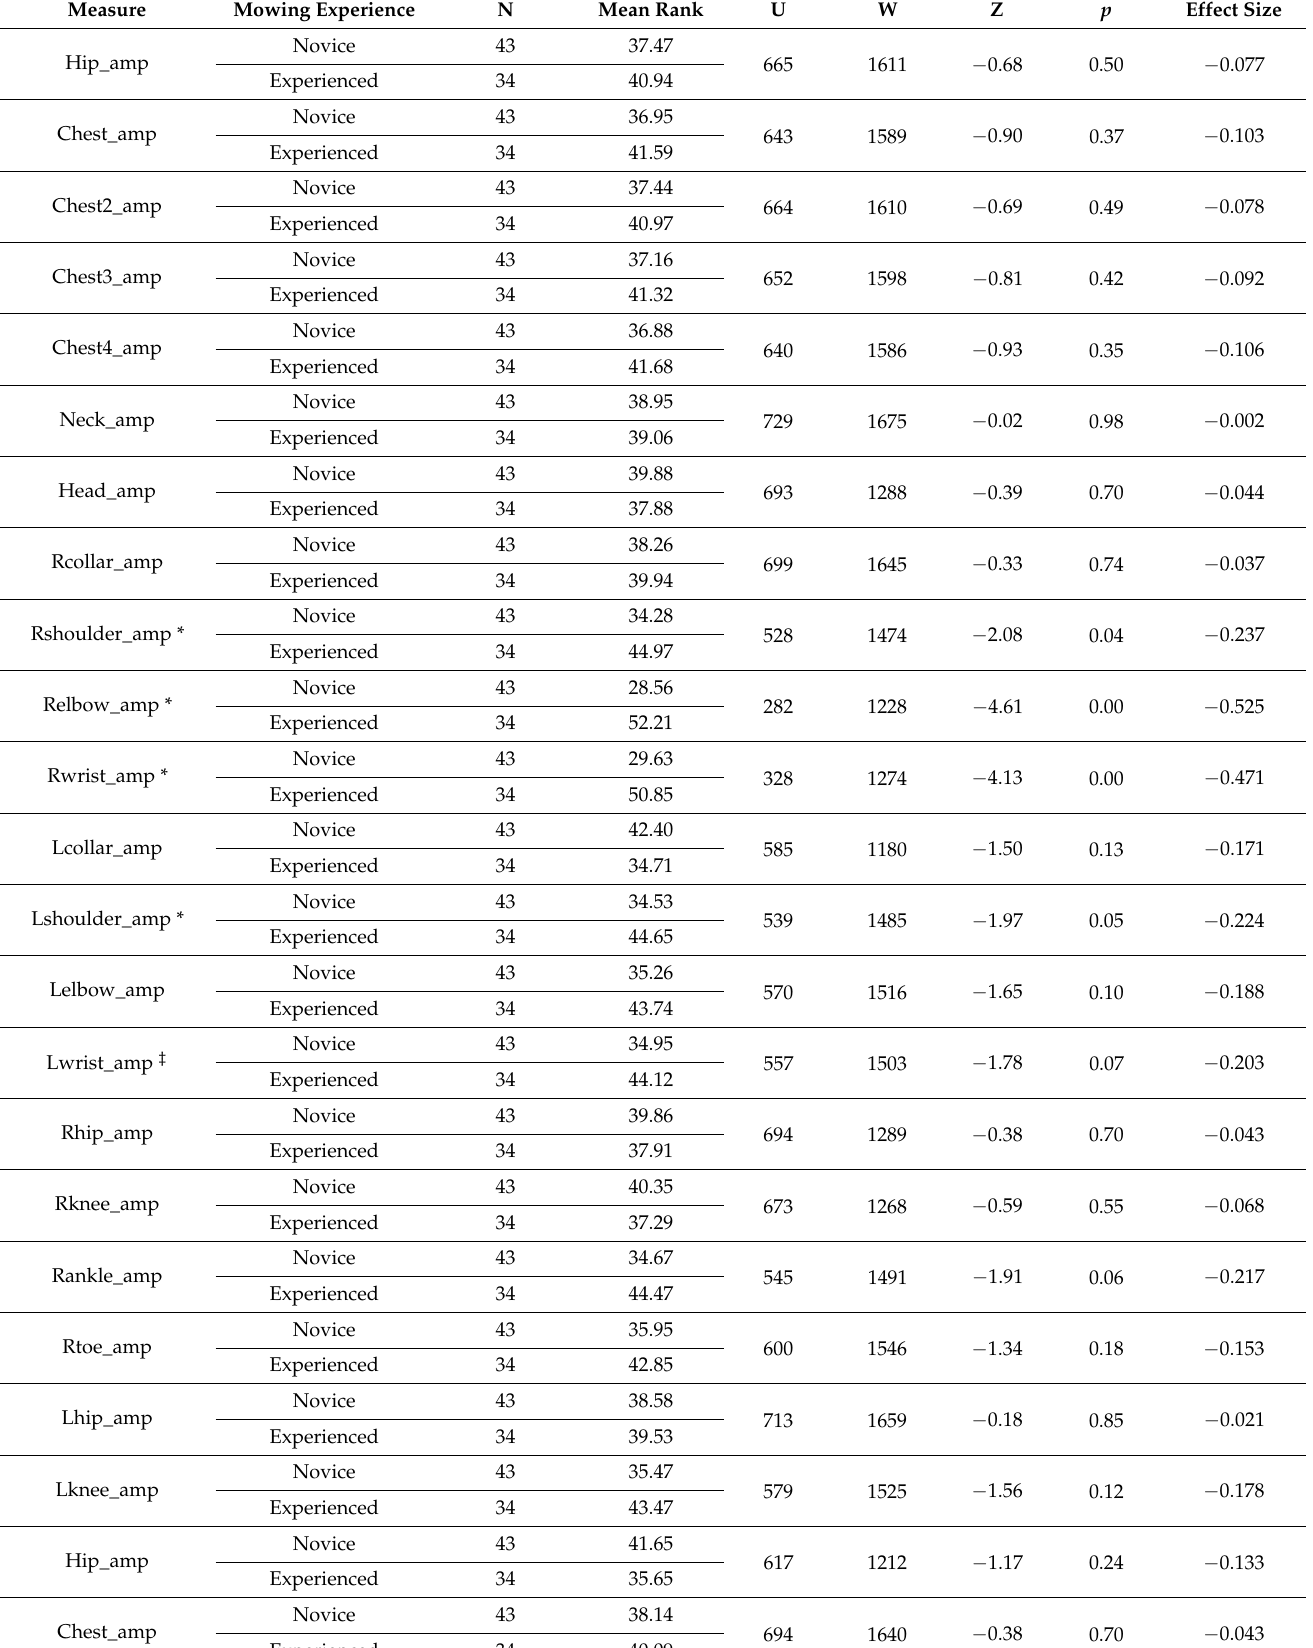
Table 5. Results for Different Mowing Experience (Amp.